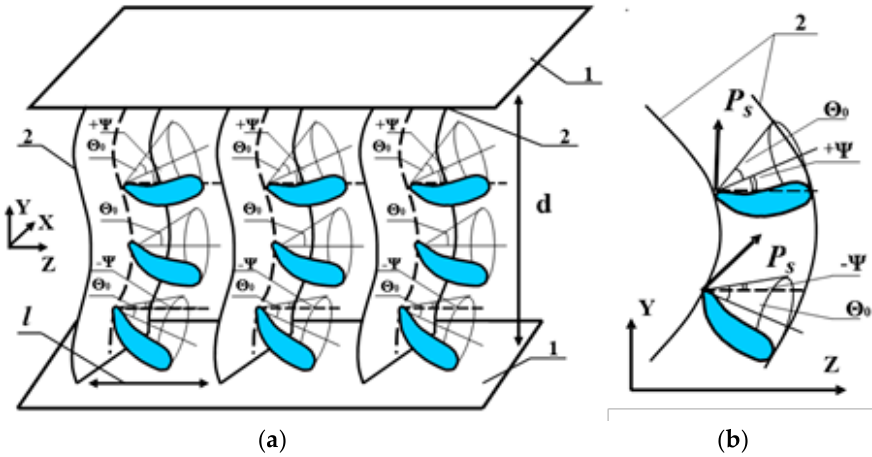
Figure 3. An electro-optical cell with helix-free FLC ( a ) and a fragment of a deformed smectic layer ( b ) 1 — glass substrates with conductive covers; 2 — smectic layers; Θ 0 — the angle of molecule tilt in ( b ) 1—glass substrates with conductive covers; 2—smectic layers; Θ 0 —the angle of molecule tilt in smectic layers; ψ — angle of tilt of a smectic layer; Р S — vector of spontaneous polarization; d — FLC cell smectic layers; ψ —angle of tilt of a smectic layer; P S —vector of spontaneous polarization; d —FLC cell thickness; l — smectic layer thickness. thickness; l —smectic layer